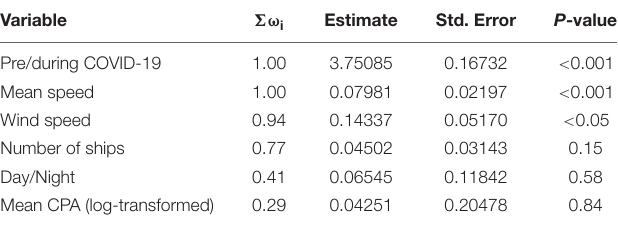
TABLE 2 | Summed Akaike weights ( (cid:54) ω i ), model averaged estimates and their standard errors and p -values for AIS and other data variables in the GLM